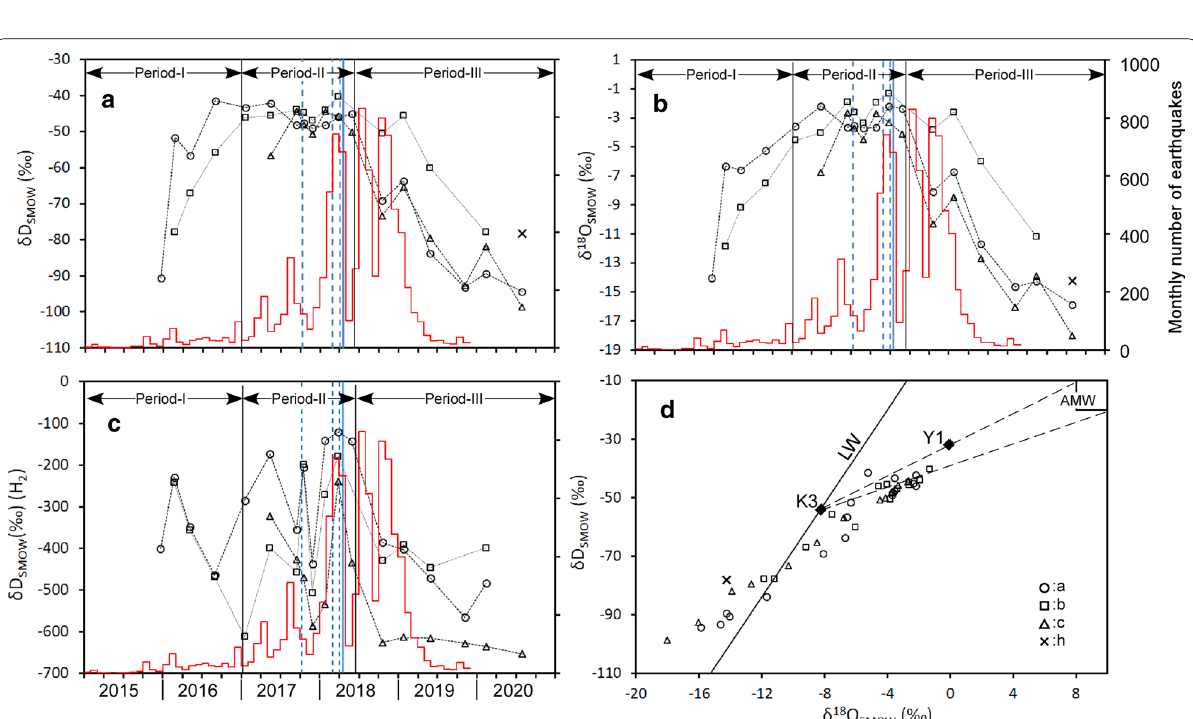
Fig. 5 a Changes in the hydrogen isotopic ratio (δD) of H 2 O. Red histogram and vertical lines have the same meaning as in Fig. 3. b Changes in the oxygen isotopic ratio (δ 18 O) of H 2 O. c Changes in the hydrogen isotopic ratio (δD) of H 2 . d δD and δ 18 O of H 2 O in fumarolic gas. AMW denotes the general region of magmatic water emitted from andesitic magma. K3 denotes the isotope ratio of local meteoric water. Broken lines show the simple mixing relationship between AMW and K3. LW denotes the local meteoric water